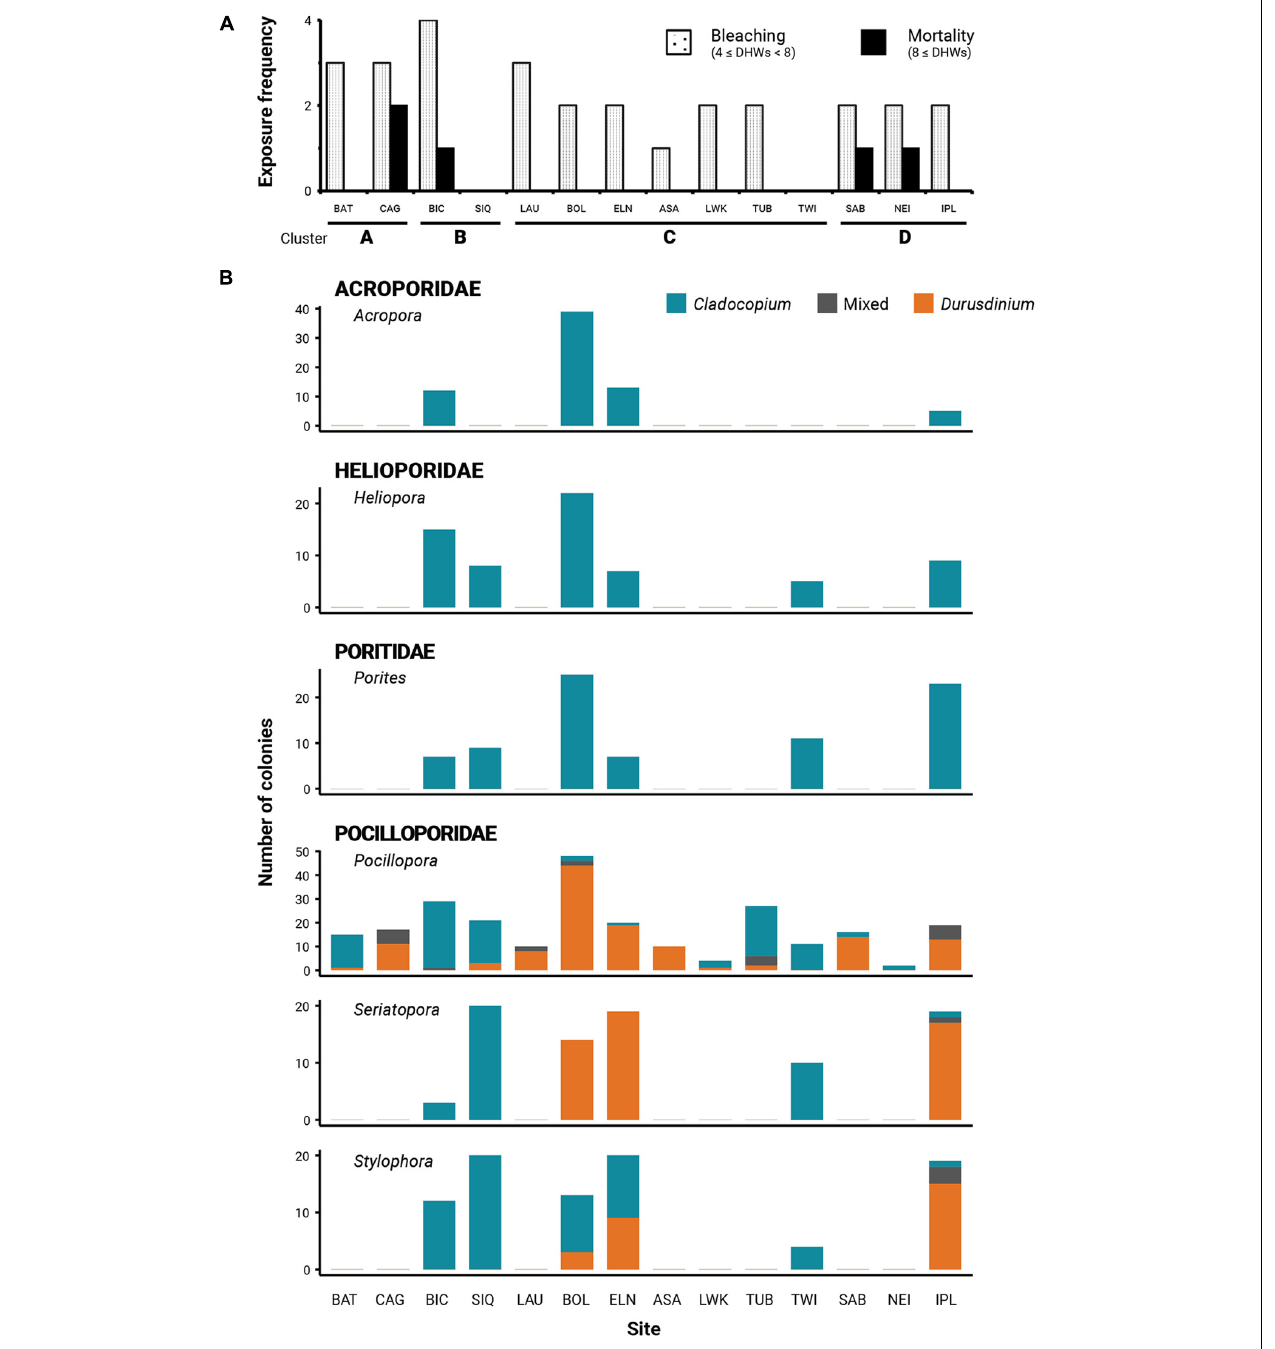
FIGURE 2 | (A) Frequency of site exposure to at least four and at least eight degree-heating weeks (DHW) indicative of prolonged thermal stress and respectively, predictive of coral bleaching and mortality; (B) Relative Cladocopium , Durusdinium , and mixed zooxanthellae occurrences across sites of different thermal histories and coral